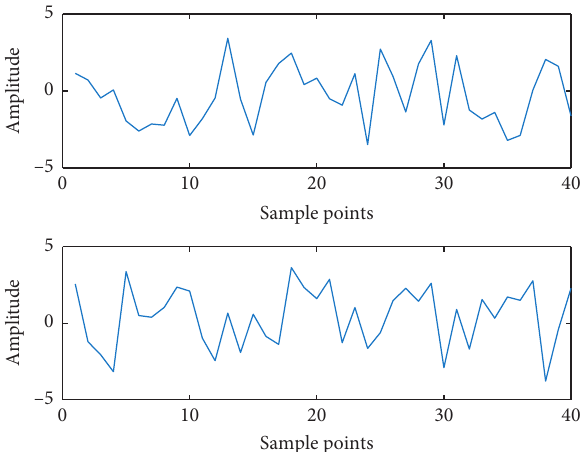
Figure 3: Music signal power spectrum under deep learning.